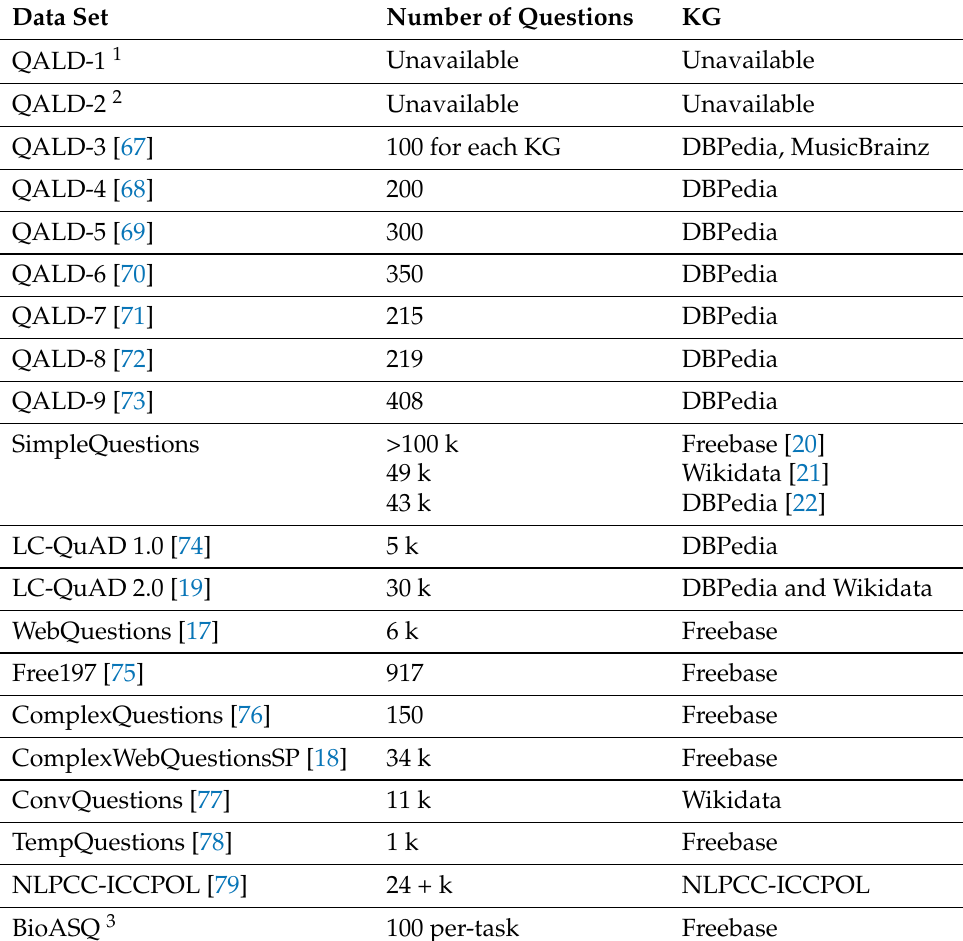
Table A1. Data set used for evaluation of KGQA